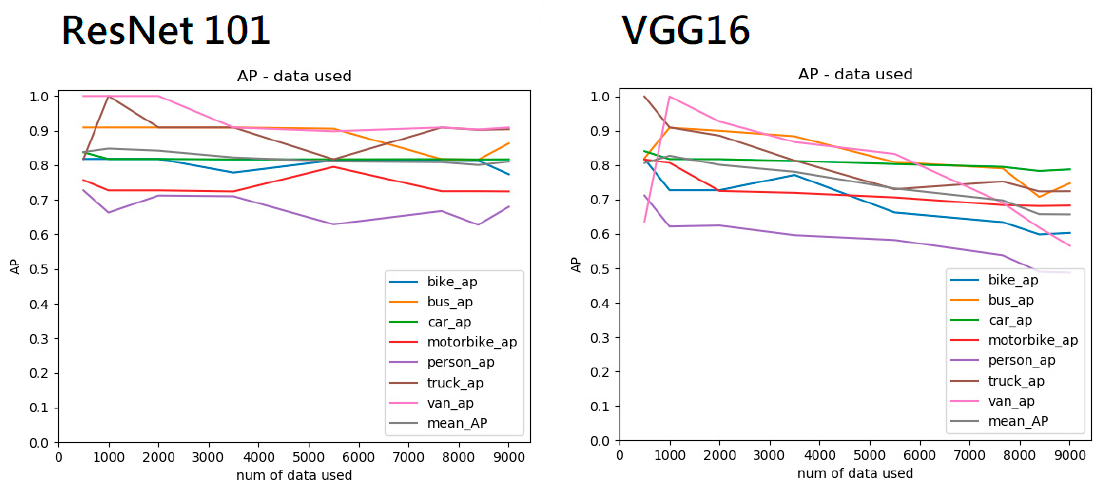
ff erent amounts of our nighttime